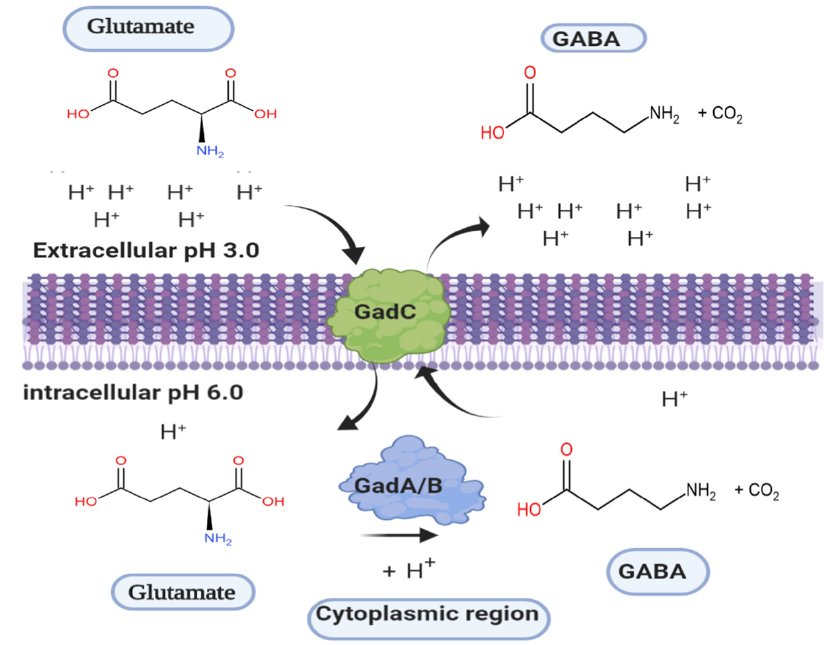
Figure 2. Schematic representation of the glutamate-dependent acid-resistance system. Glutamate (net charge 0) is taken up by the l -glutamate / GABA antiporter GadC, while concurrently GABA is exported by GadC as indicated by the arrows. Subsequently, GadA / B catalyze the decarboxylation of glutamate by consuming an intracellular proton (H + ) at each cycle and generate the proton motive force by GABA export (net charge +1).